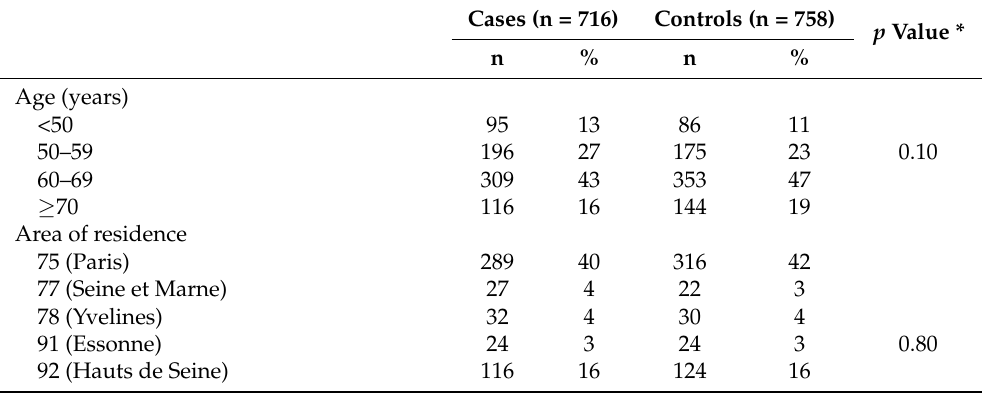
Table 1. Characteristics of cases and